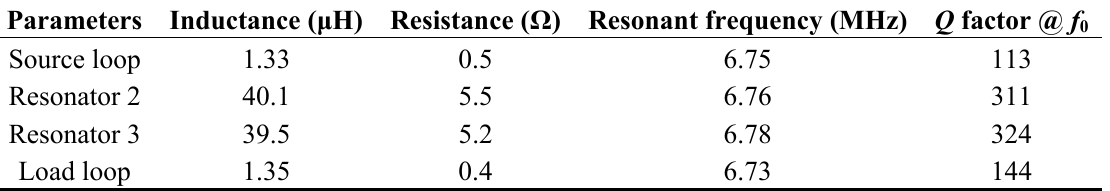
Table 1. Measured electrical parameters of